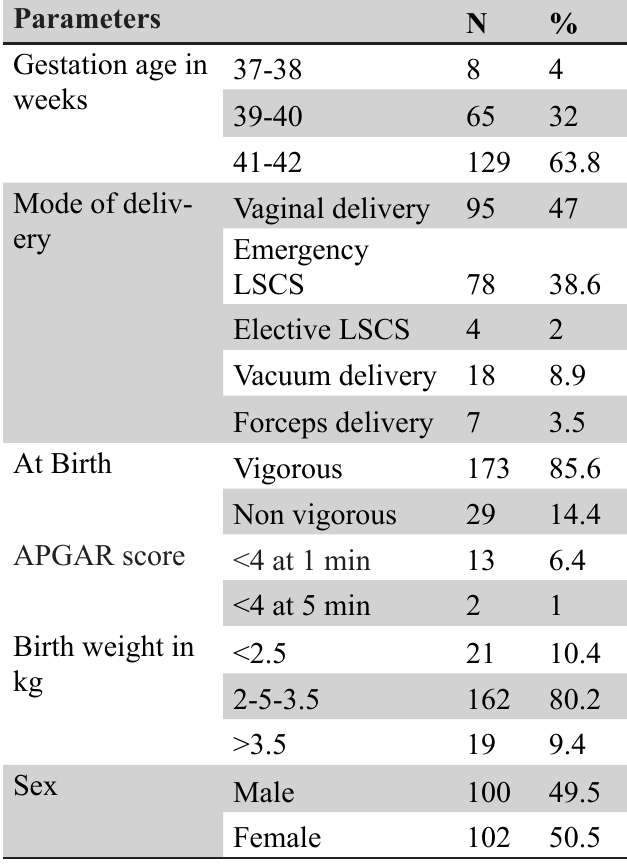
Table 3. Clinical profile of babies with